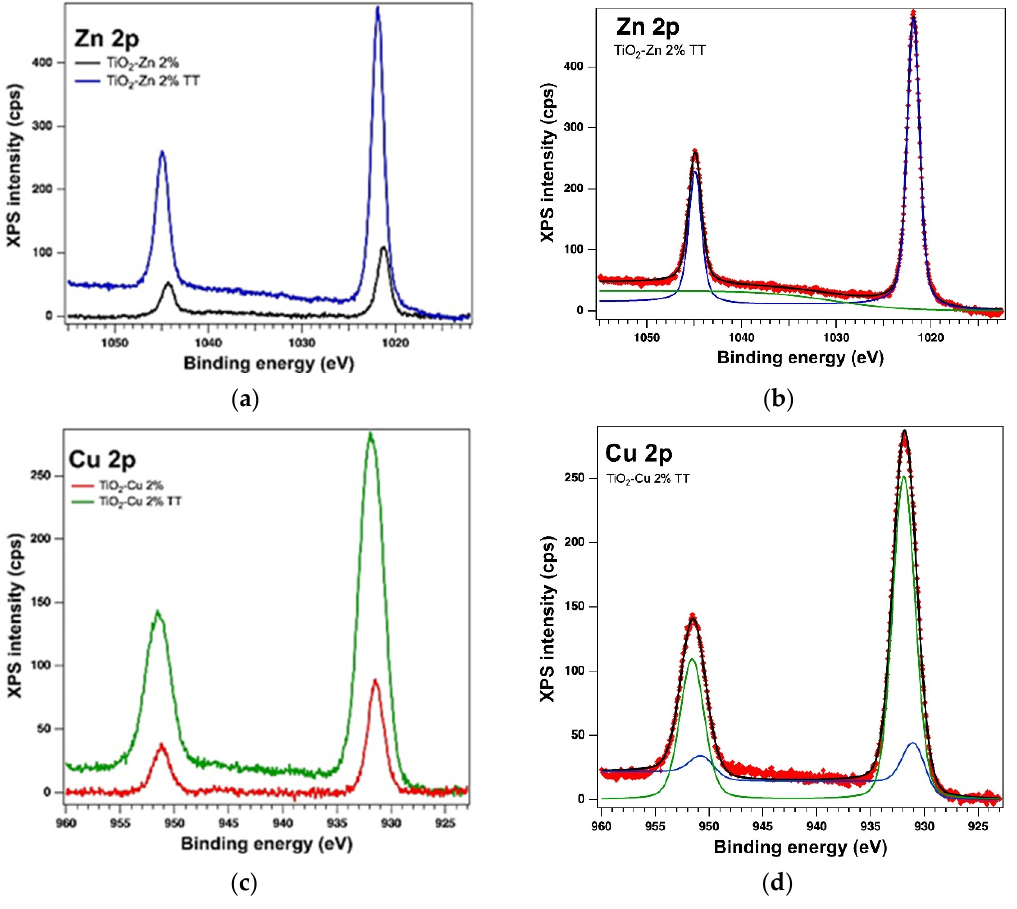
Figure 12. XPS spectra of the core levels Zn 2p ( a ) and Cu 2p ( c ) overlayed XPS spectra of both kinds of samples and the experimental data (red symbols) with the fit and deconvolutions for ( b ) the thermally treated sample with Zn (deconvolution with component C1–blue line; the green line represents an Auger line, which is not taken into account in the chemical analysis) and ( d ) the thermally treated sample with Cu (deconvolutions: components C1–blue line and C2–green line). Table 4. Binding energies, at. % and interpretation of the components of the core levels of interest for the thermally treated